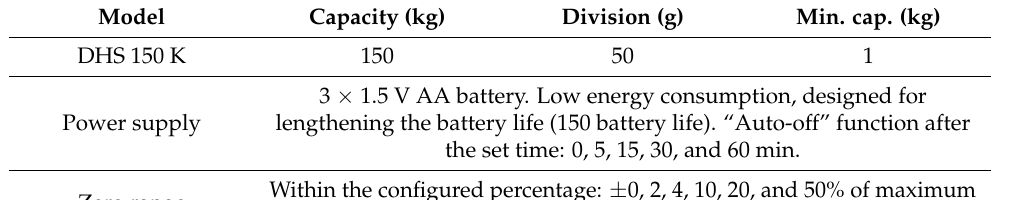
Table 2. Technical specifications of the dynamometer.